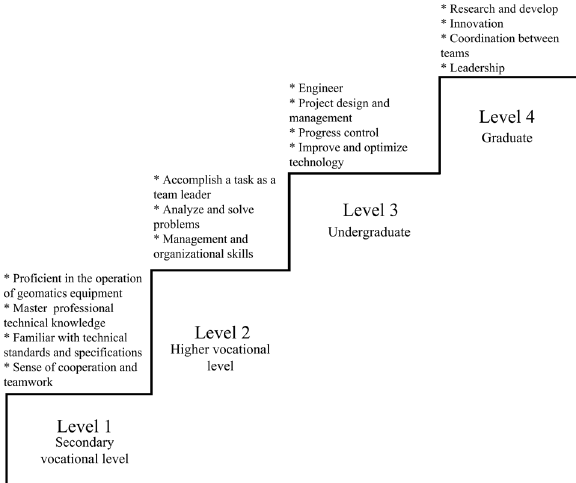
Figure 3. The competencies of different levels of geomatics